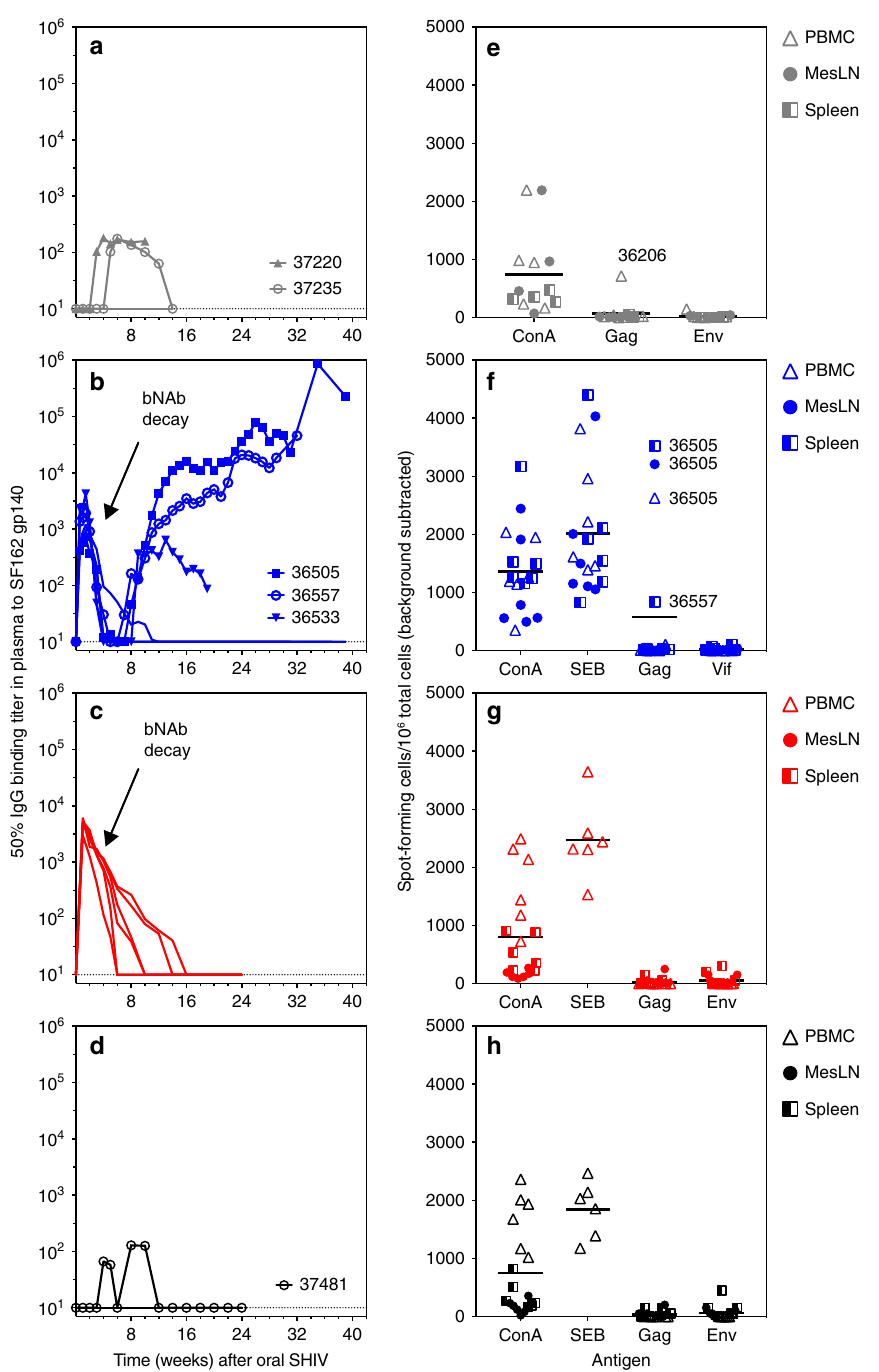
Fig. 5 bNAbs and ART modulate adaptive immunity. a – d Plasma IgG binding titers to SF162 Env protein (gp140) were measured by ELISA. Group colors and individual animal symbols are consistent throughout the manuscript. The animal number is indicated for animals that had positive antibody responses to SF162 gp140. b , c In Groups 2B and 3, the period of bNAb decay (rather than endogenous antibody response) is indicated by arrows. e – h T cell responses to HIV-1 Env antigen, SIVmac239 Gag ORF 15-mer peptide pool, or SIVmac239 Vif ORF 15-mer peptide pool were measured by IFN γ ELISPOT. SF162 gp140 protein was used as the Env antigen for all samples except for peripheral blood mononuclear cells (PBMC) for Groups 3 and 4 ( g , h ), for which Clade B consensus Env ORF 15-mer peptide pools were used. T cell responses in PBMC, mesenteric lymph nodes (MesLN), and spleen were quanti fi ed at time of death. Concanavalin A (ConA) and/or Staphylococcal Enterotoxin B (SEB) were used as positive stimulation controls. For each group, horizontal lines indicate the grand mean of ELISPOT responses to each antigen used for stimulation. Different tissue types (PBMC, MesLN, spleen) are indicated with individual symbols as shown. For speci fi c tissue samples in which positive T cell responses to viral antigens were measured, the animal number is indicated next to the symbol. Group colors are consistent throughout the manuscript. Source data are provided as a Source Data fi